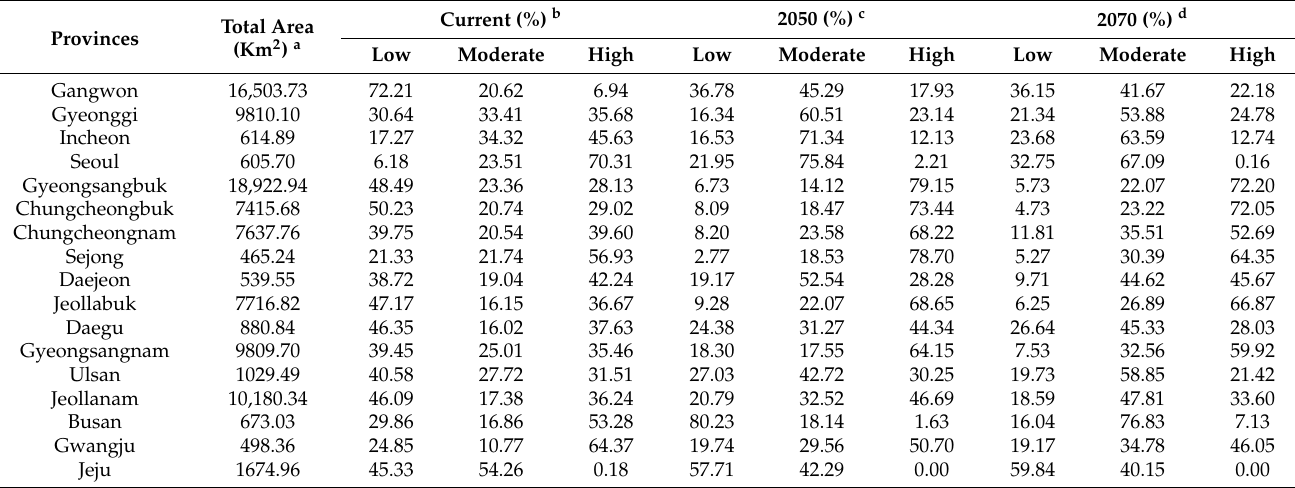
Figure 7. Average invasion risk at the district level under the current ( A ) and future ( B , C ) environ- mental conditions in South Korea. The red colors in the figure indicate the highest average invasion risk, and the green colors indicate the lowest average invasion risk. Table 5. Area in each invasion risk category relative to the total area of the province or major city, under current and predicted environmental changes in South